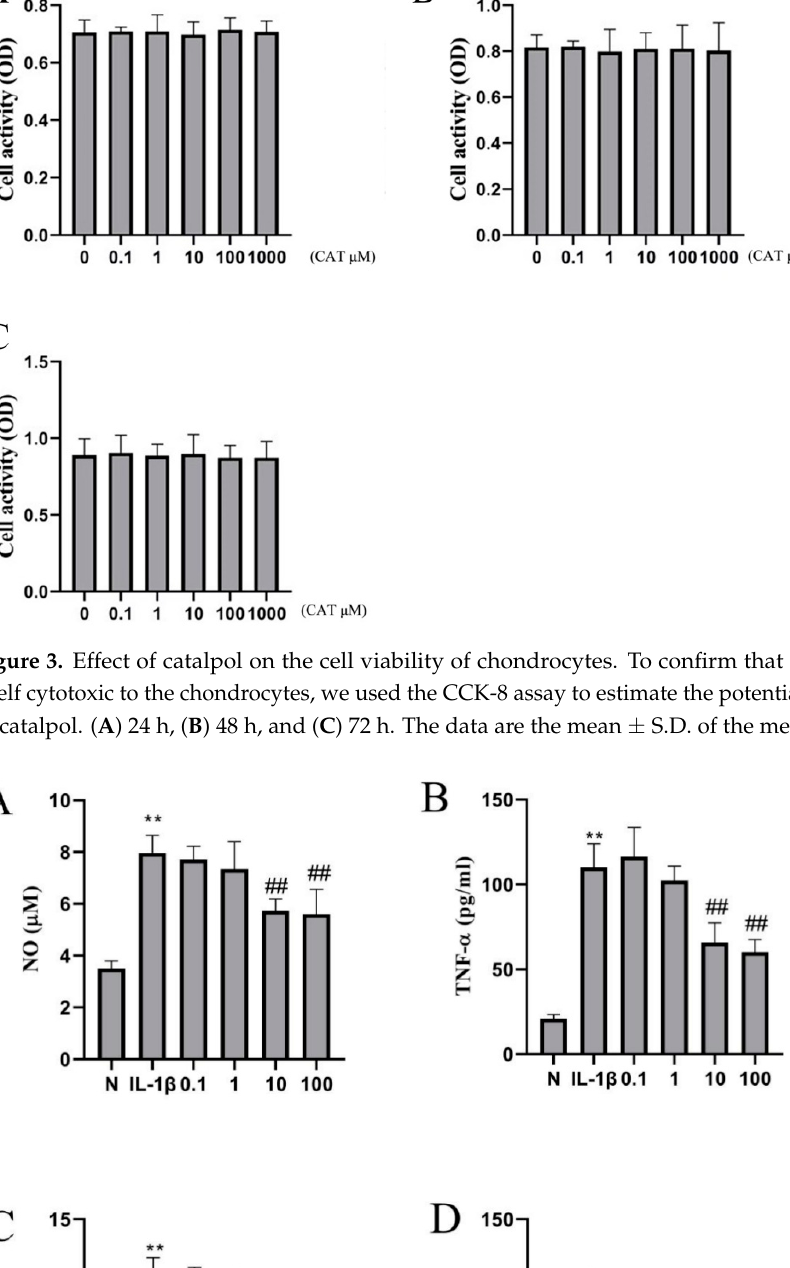
μ M ( p < 0.01) catalpol significantly attenuates TNF- α levels evoked by IL-1 β (10 ng/mL) in the supernatant of chondrocytes. An amount of 1 μ M catalpol ( p < 0.05), 10 μ M ( p < 0.01) catalpol, and 100 μ M catalpol ( p < 0.01) significantly lowered the IL-1 and IL-6 levels in chondrocytes evoked by IL-1 β (10 ng/mL)-induced inflammation. Referring to these re- sults and the result of the CCK-8 assay, we chose 10 μ M of catalpol in the subsequent experiment. 2.5. The Effects of Catalpol on the Levels of Inflammasome Activation-Associated Proteins and mRNA As shown in Figure 5, the qPCR results confirmed that inflammatory mRNA cytokine (IL-1, IL-6, and IL-12) levels were increased after IL-1 β induction ( p < 0.01). Catalpol sig- nificantly inhibited the mRNA expression of IL-1, IL-6, and IL-12 in chondrocytes induced by IL-1 β . These results were consistent with the results of our previously mentioned ELISA analysis. The above results proved that catalpol possessed a favorable anti-inflam- matory effect on chondrocytes induced by IL-1 β . As shown in Figure 6, significant